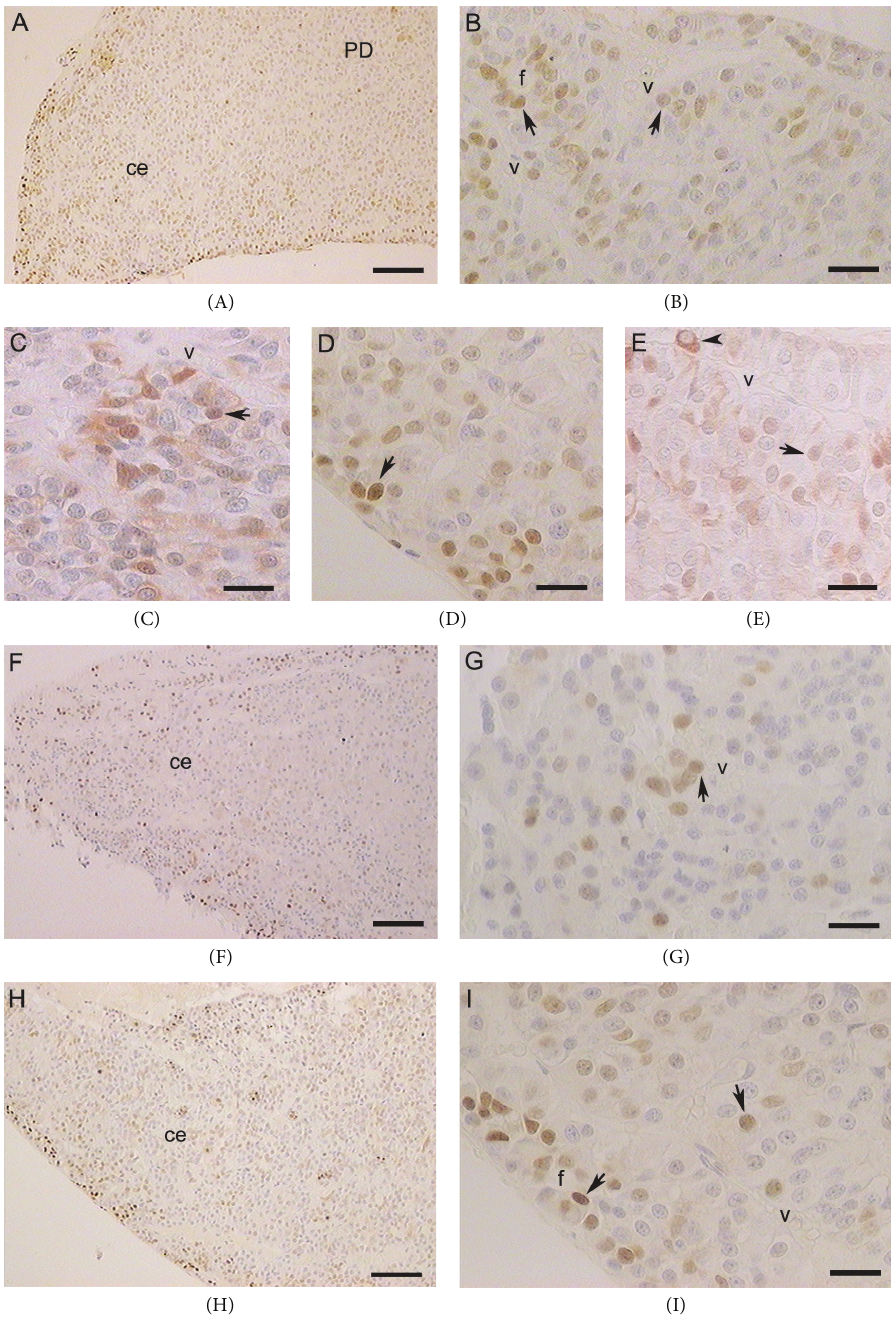
Figure 4: Seasonal expression of AR in pituitary during the reproductive cycle of adult viscachas. ((A)–(E)) Reproductive period. ((A), (B)) Images of caudal end; the AR were expressed mainly in the nuclei of PD cells (arrows). ((C), (D), and (E)) AR expression at the rostral end, ventral region, and dorsal region, respectively. The arrowhead indicated a cell with cytoplasmic labeling for AR. ((F), (G)) A few AR-ir cells at caudal end during the gonadal regression period. ((H), (I)) AR-ir cells at caudal end during the gonadal recovery period. Caudal end, ce; blood vessels, v; follicular structures, f. ((A), (F), and (H)) Scale bar 100 𝜇 m. ((B), (C), (D), (E), (G), and (I)) Scale bar 25 𝜇 m. Images counterstaining with